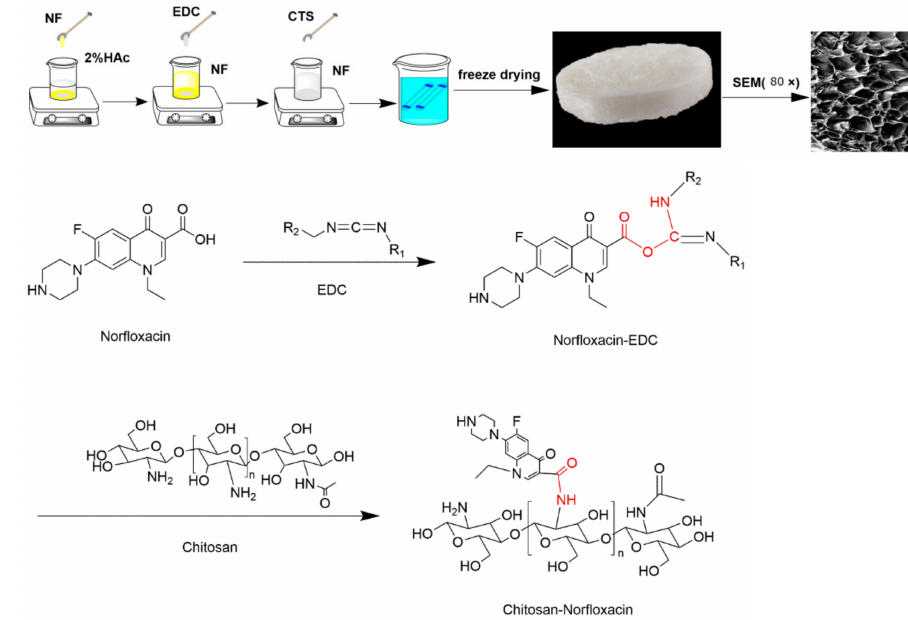
Figure 1. Preparation of the CTS-NF composite sponge.